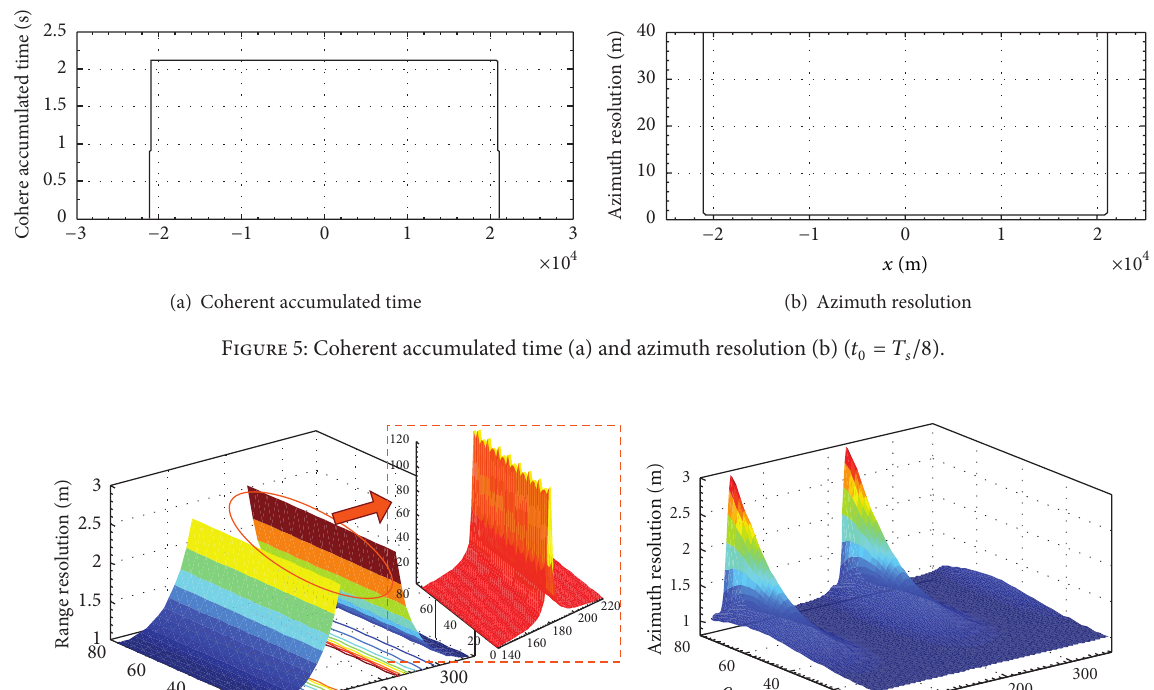
and Ψ for GEO-UAV BiSAR. in